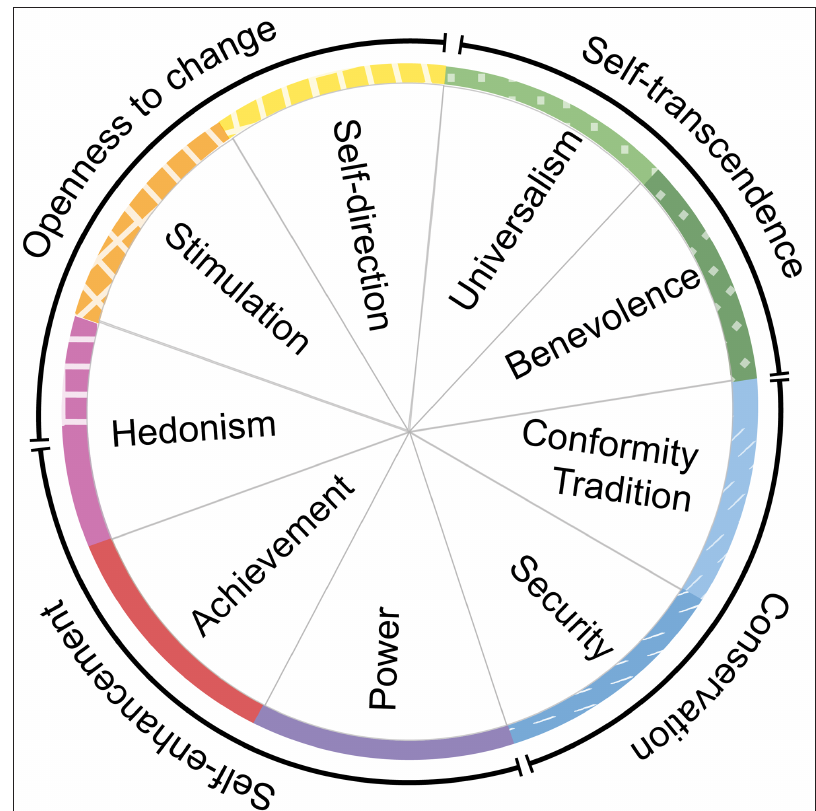
Figure 1: Schwartz’s Human Values circumplex (adapted from Schwartz